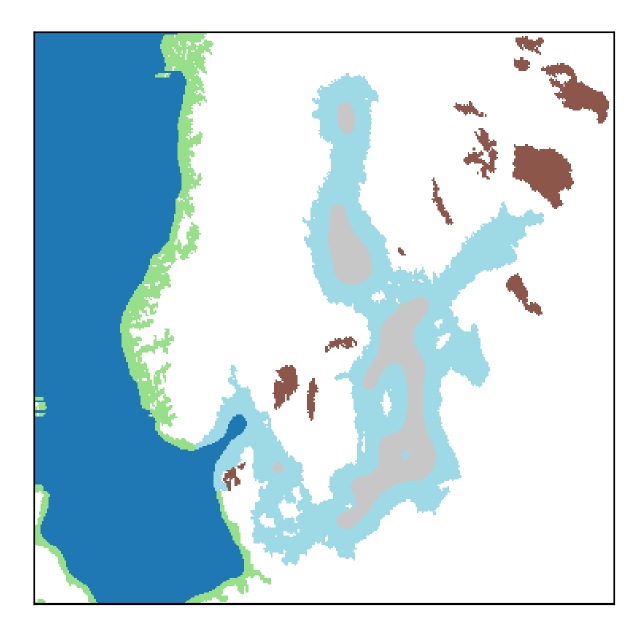
Figure 4. Baltic and North Sea region of the mask used to determine which sea ice analysis grid points require additional processing. Green points are coastal and are not sufficiently covered by the input data. These are infilled from the dark blue regions. In the Baltic Sea, only the grey region is covered by the input data. This and the light blue region are augmented by using the SST to determine if ice is present. This method to infer ice from the temperature is also applied to lakes (brown